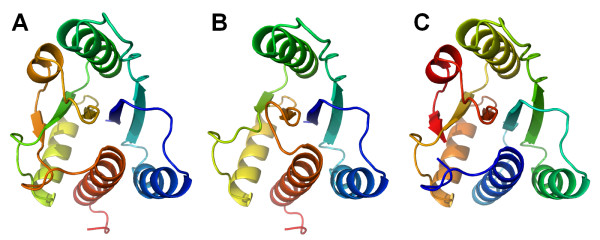
Possible origins of the knot. A) Contemporary knotted SPOUT fold, exemplified by E. coli YbeA (1ns5). B) Putative ancestral structure, 'unknotted' by deletion of an α/β unit. C) Alternative putative ancestral structure, 'unknotted' by circular permutation, i.e. linking 'old' termini and cutting the knot to create new termini. Protein sequence is colored from blue (N-terminus) to red (C-terminus).